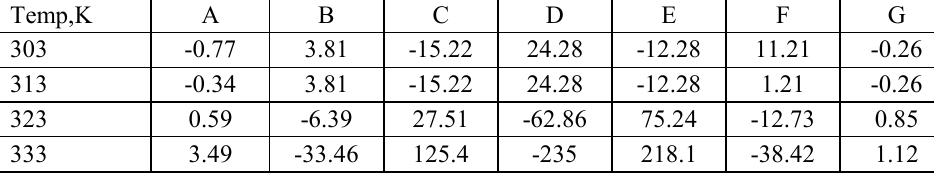
Table 6. Effect of the sodium